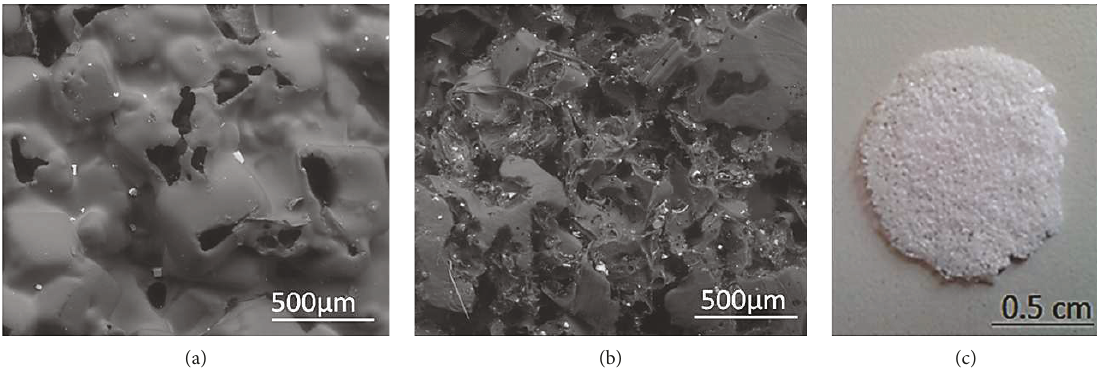
Figure 2: SEM images show front (a) and back (b) surfaces of nontreated sponge. (c) P